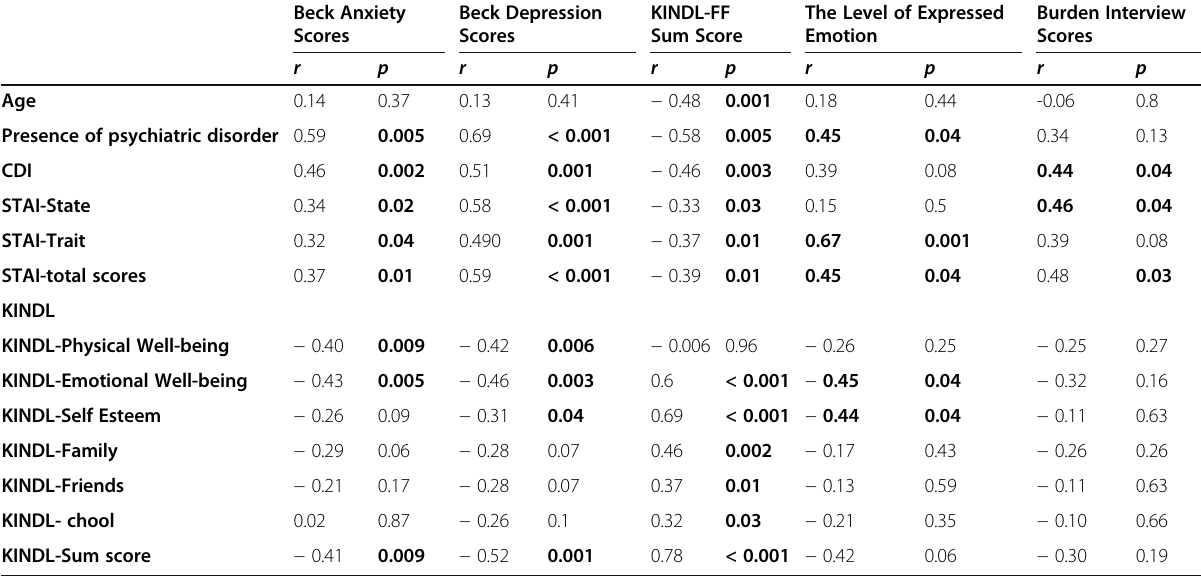
Table 5 Correlation of the outcomes of KINDL with other scales of children and